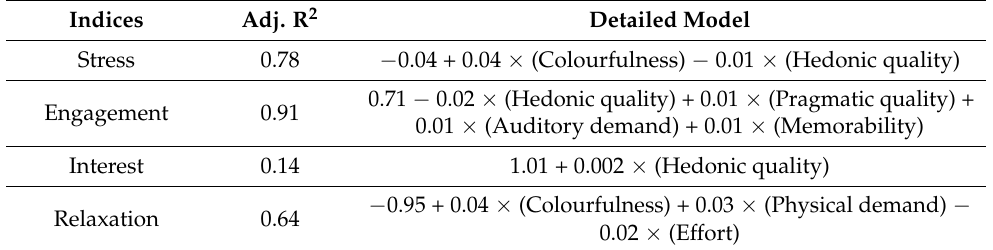
Table 5. Modelling results for psychophysiological